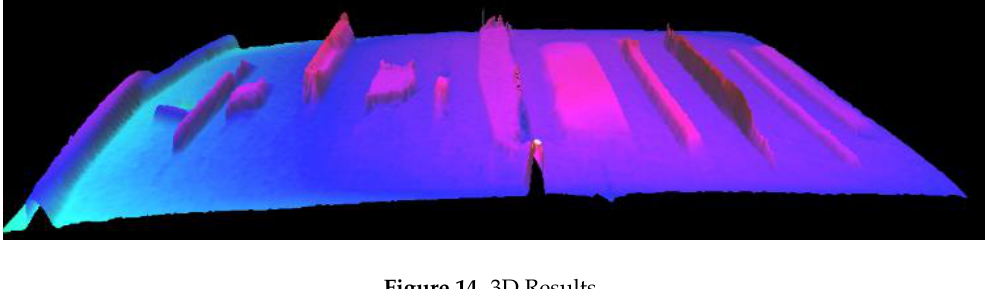
Figure 14. 3D Results.